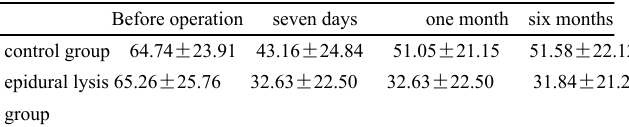
TABLE 3 - Effect standard of Macnab lumbar disease six months after the treatment. Excellent Good Common Bad Excellent and good rate Control group Table 4 illustrates opioid intake between both groups. TABLE 4 - Daily opioid (morphine equivalents) before operation, seven days, one month, six months post operation.